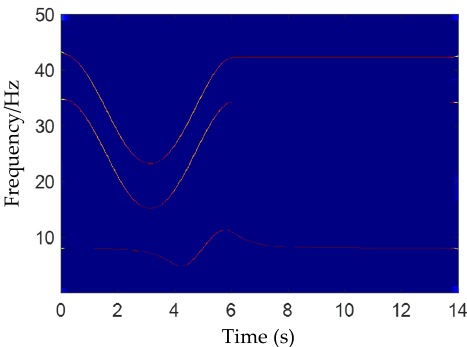
Figure 3. TF distribution of the simulated signal based on SET.